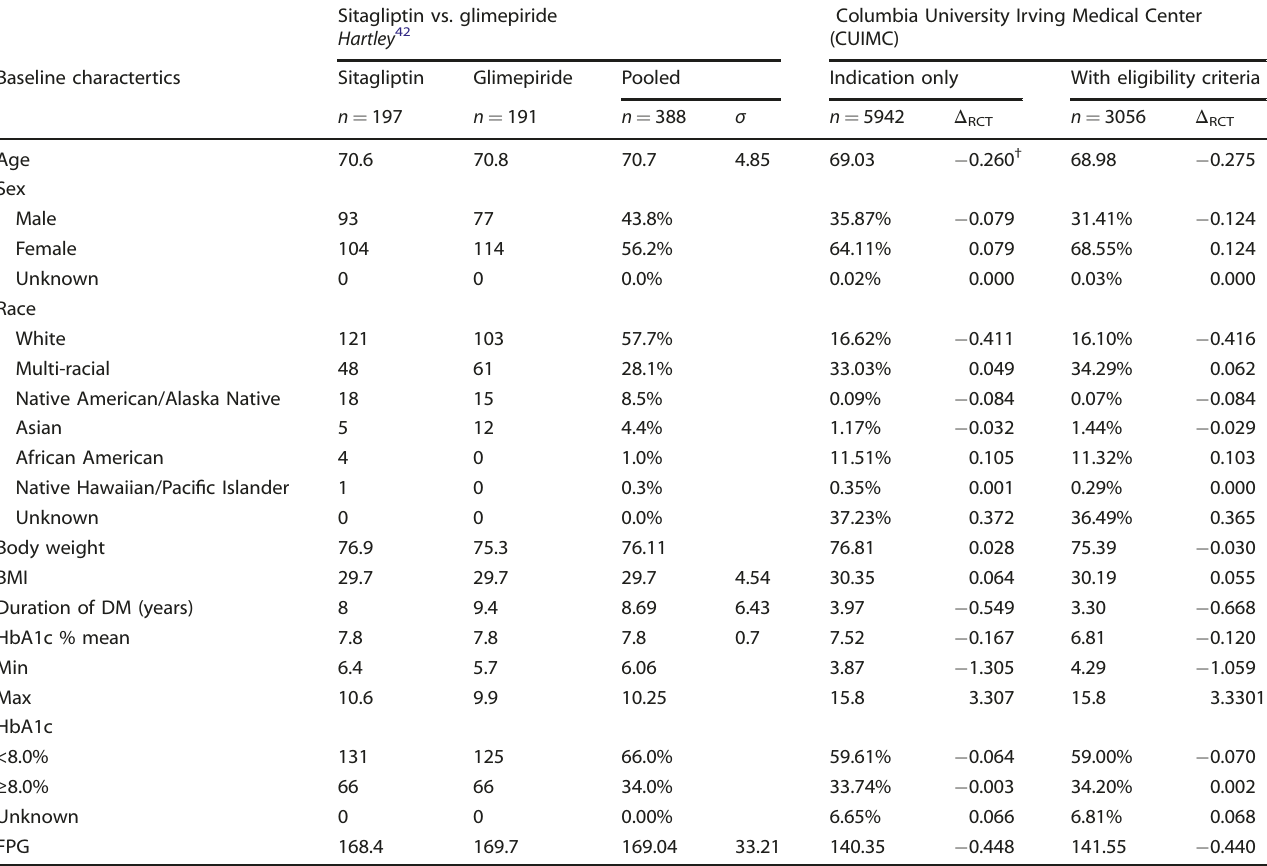
Table 1. Results for sitagliptin vs. glimepiride